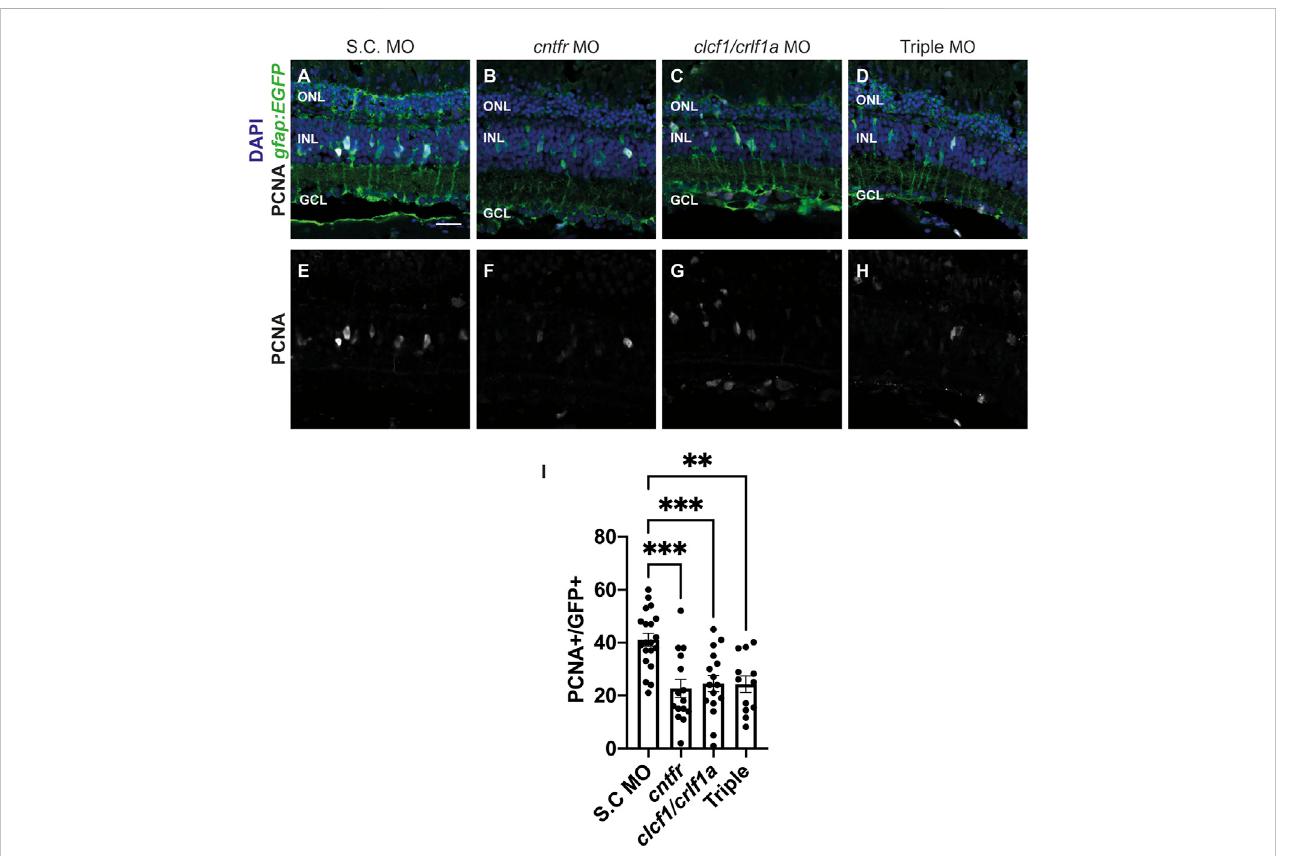
FIGURE 5 Knockdown of CNTFR and Clcf1/Crlf1a reduces Müller glia proliferation. (A – H) Single confocal images from dark-adapted albino; Tg[gfap:EGFP] nt11 zebra fi sh which were light-treated for 36 h after electroporation of either S.C. (A) , cntfr (B), clcf1/crlf1a morpholinos (C), or a combination of all three cntfr/ clcf1/crlf1a (Triple) (D) . Sections were labeled for GFP and PCNA to assess proliferating Müller glia and nuclei were counterstained with DAPI (E, F, G, H) . (I) Quanti fi cation showing signi fi cant decrease in the number of PCNA-positive Müller glia within the INL in cntfr and clcf1/crlf1a electroporated retinas. One-way ANOVA with Dunnett post hoc , cntfr vs. S.C. p < 0.0001, clcf1/crlf1a vs. S.C. p = 0.0003, Triple vs. S.C. p = 0.0072. n ≥ 12. Mean ± SEM, ** p < 0.001, *** p < 0.001, **** p < 0.0001. ONL, outer nuclear layer, INL, inner nuclear layer, GCL, ganglion cell layer. Scale bar represents 20